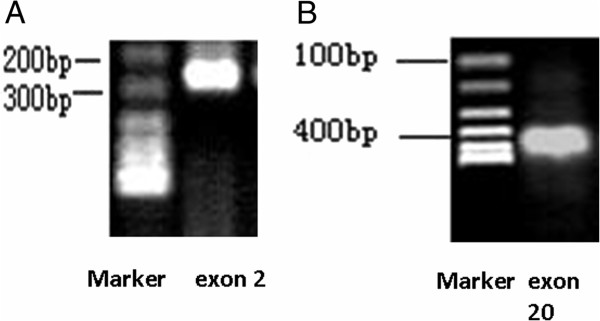
A The PCR product of exon 2 of the BRCA1 gene (259 bp). B The PCR product of exon 20 of the BRCA1 gene (401 bp).